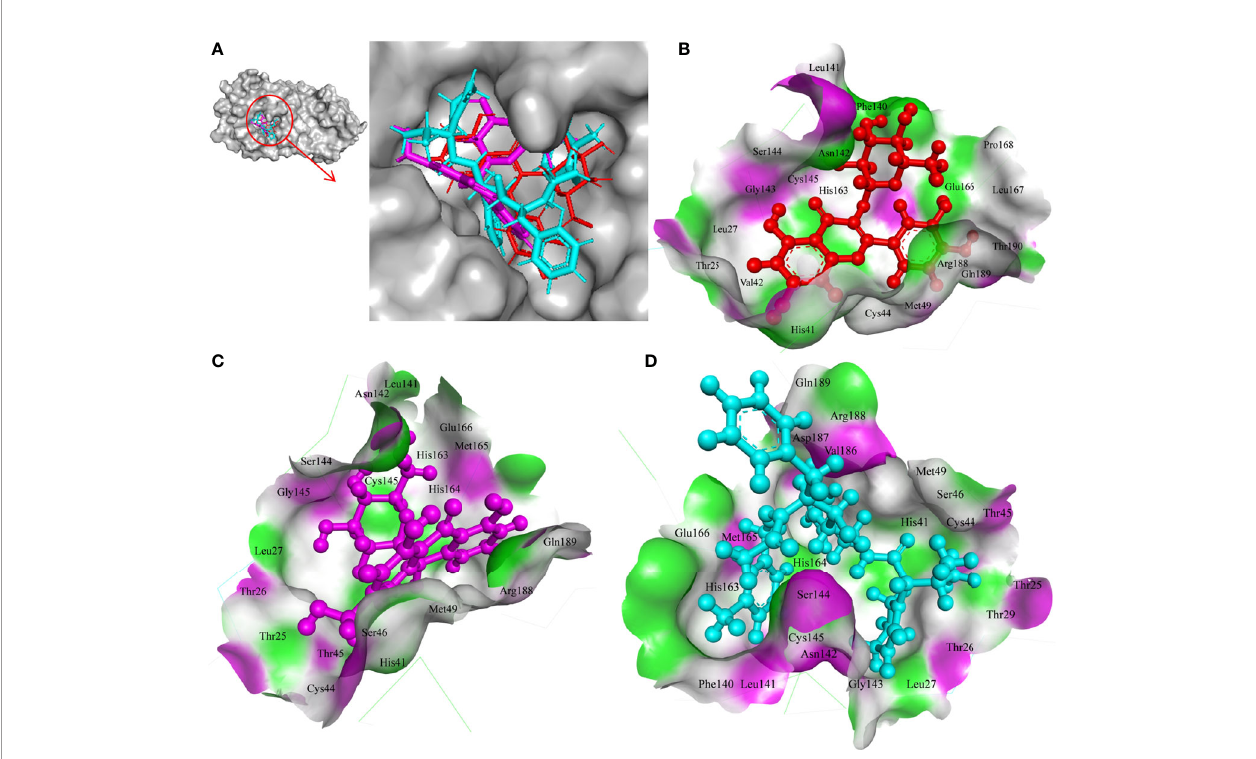
FIGURE 2 | Interaction of lead phytochemicals and standard inhibitor at the M pro active site. (A) Binding pose of lopinavir (Cyan), Isoquercetin (Red), and 10- Hydroxyaloin A (Pink). (B) Interaction of M pro protein with isoquercetin shown with the hydrogen bond surface of receptor. (C) Interaction of M pro protein with 10- Hydroxyaloin A shown with the hydrogen bond surface of receptor. (D) Interaction of M pro protein with lopinavir shown with the hydrogen bond surface of receptor.